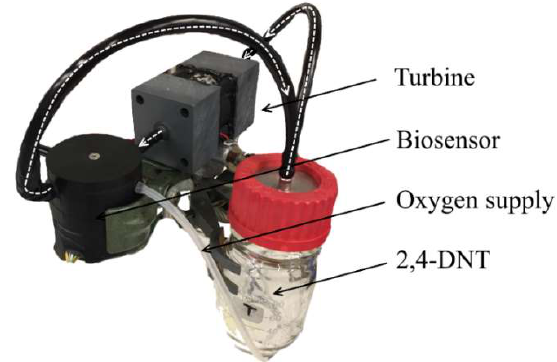
aluminum bolt was removed and the hydrogel could be casted in the casting mold ( b ).